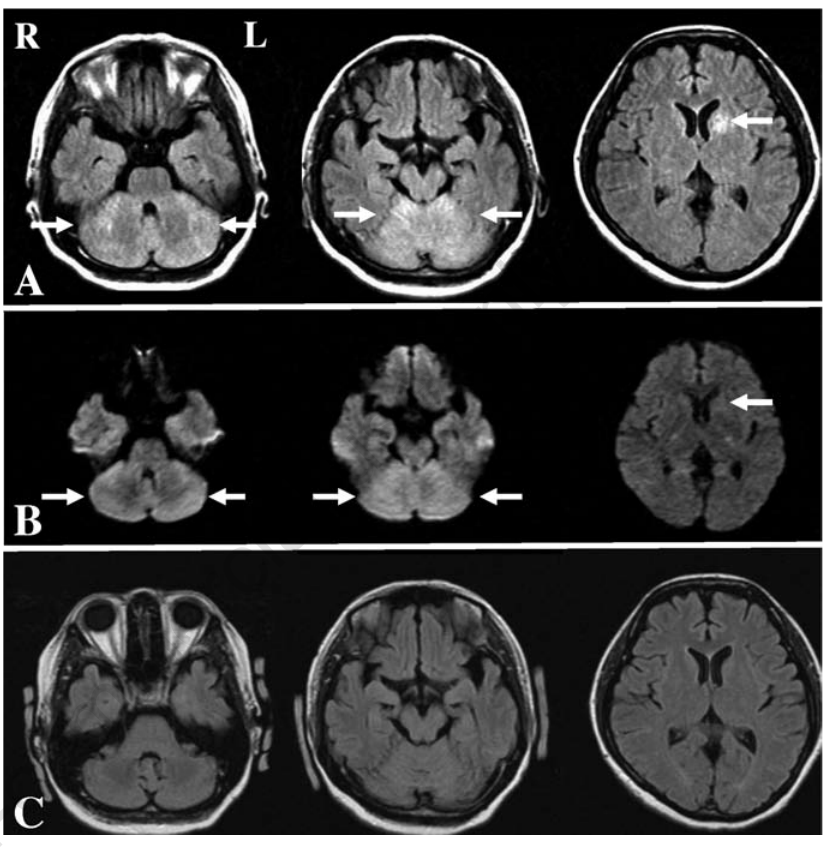
Figure 2. Brain magnetic resonance imaging 13 days after admission in Case #2. Serial images of axial fluid-attenuated inversion recovery and diffusion-weighted images show- ing high-intensity signals in the bilateral cerebellar cortex and left caudate nucleus (A and B, arrows). Follow-up fluid-attenuated inversion recovery images at 27 days after admis- sion showed that the high-intensity signals in the bilateral cerebellar cortex and left cau- date nucleus were markedly decreased (C).